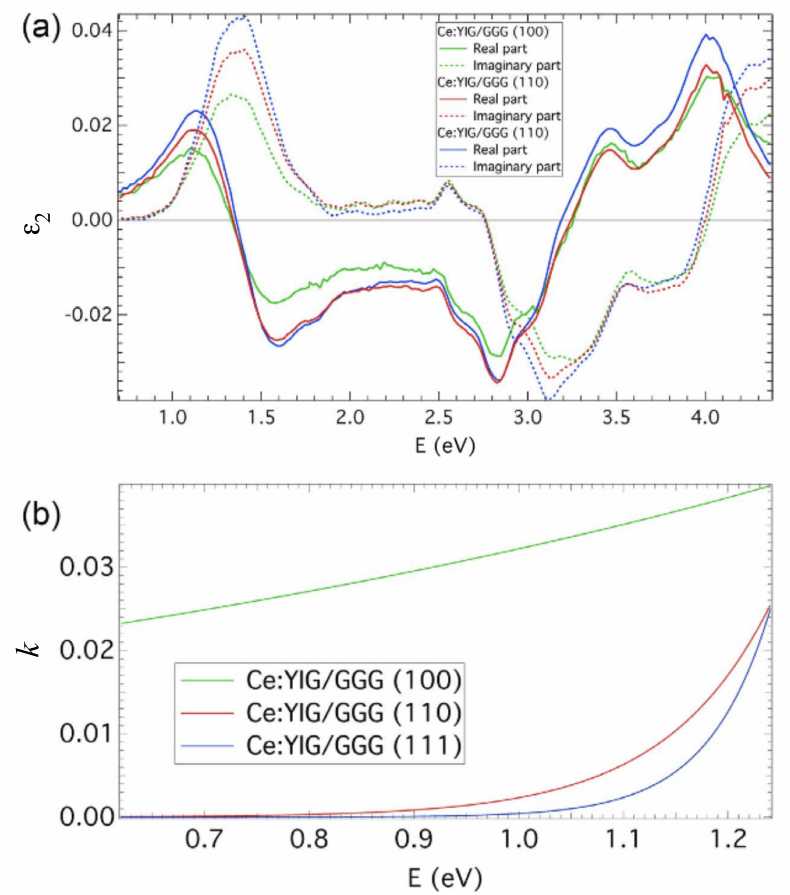
Figure 6. The real and imaginary parts of the off-diagonal permittivity component ( ε 2 ) and the extinction coefficient ( k ) are shown as a function of the incident wavelength in ( a , b ), respectively, for three Ce:YIG samples on GGG substrates. Adapted with permission from ref. [116]. Copyright 2016 Springer